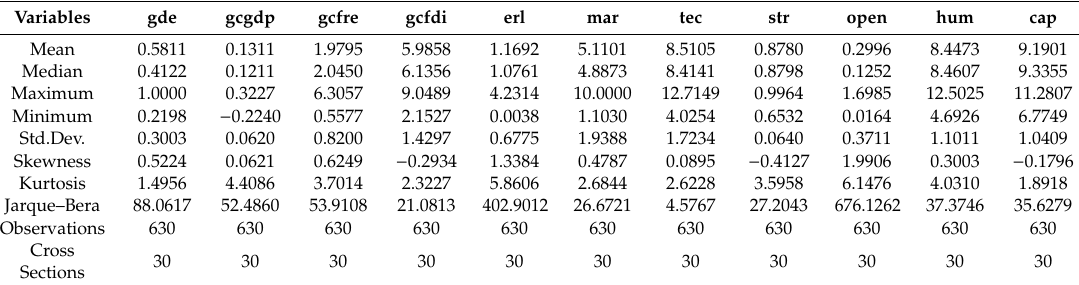
Table 4. Descriptive statistics of